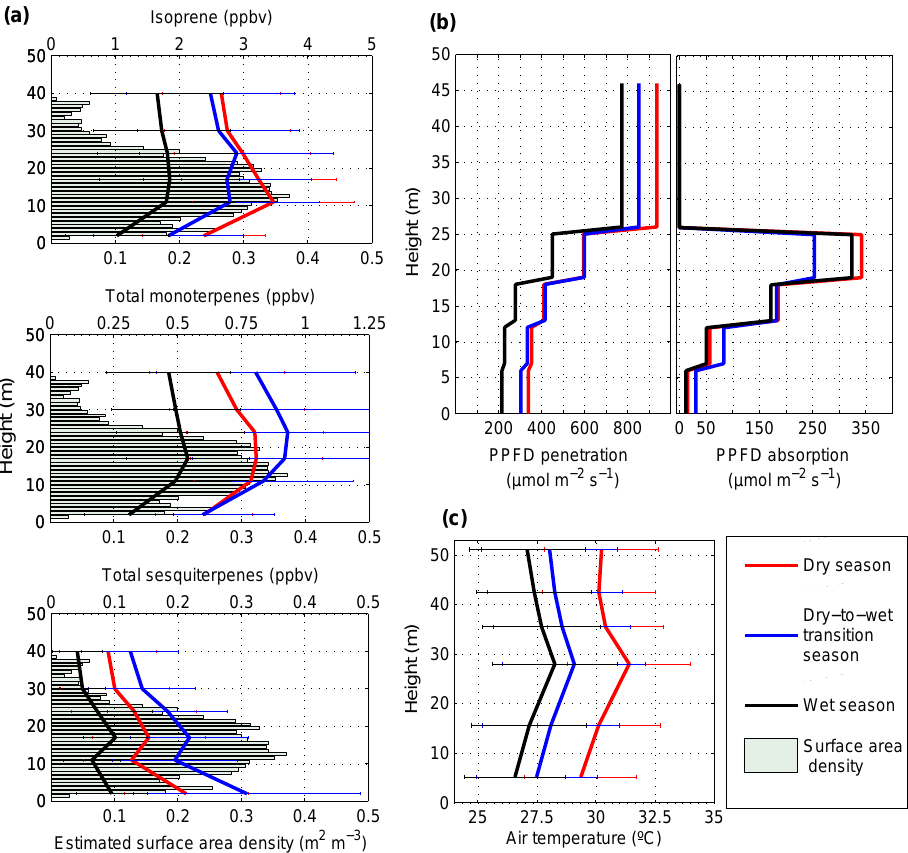
Figure 3. Daytime (10:00–16:00, LT) vertical profiles of mixing ratios of isoprene, total monoterpenes and total sesquiterpenes from the dry season to the wet season; and estimated surface area density of the canopy at this study site (ground-based measurements carried out in March 2004 using LIDAR – Light Detection And Ranging) (Parker and Fitzjarrald, 2004) (a) . Vertical profile of photosynthetic photon flux density (PPFD) penetration and absorption by the canopy from the dry season to the wet season modeled by MEGAN 2.1 (b) . Daytime (10:00–16:00, LT) air temperature profiles from dry season to wet season measured at K34 tower (c) . In Fig. 1a the top and the bottom x axis represent isoprenoid mixing ratios and estimated surface area density of the canopy, respectively. Error bars represent 1 standard